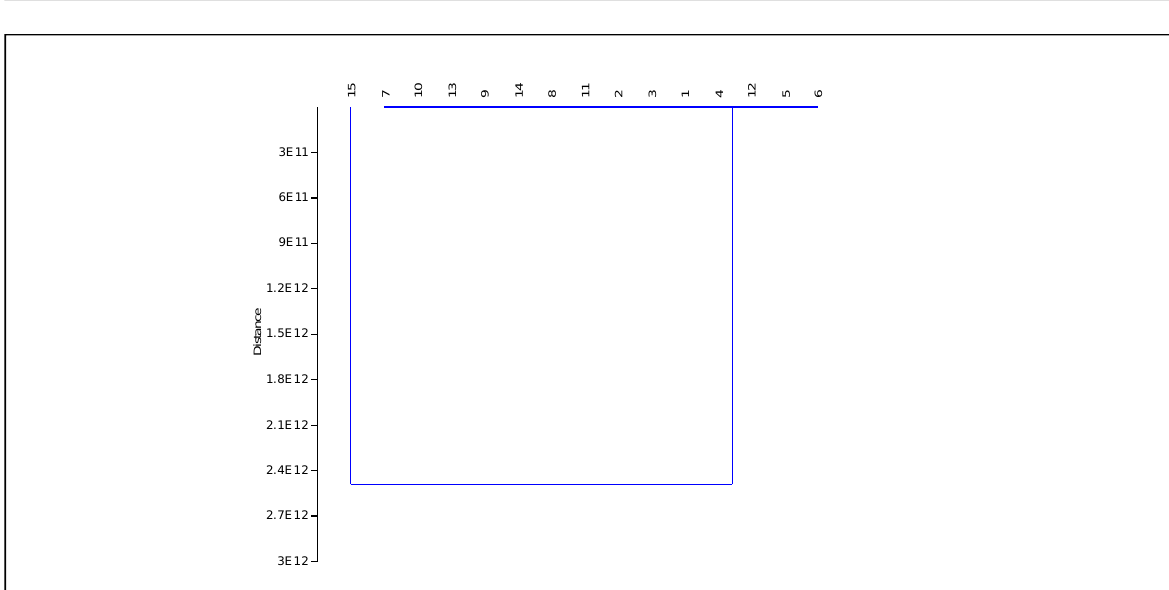
Figure 5: Dendrogram representing expression profiles that shows the relationship of CarE genes observed in both susceptible and resistant strains using LmcesA20 primers measured by qPCR